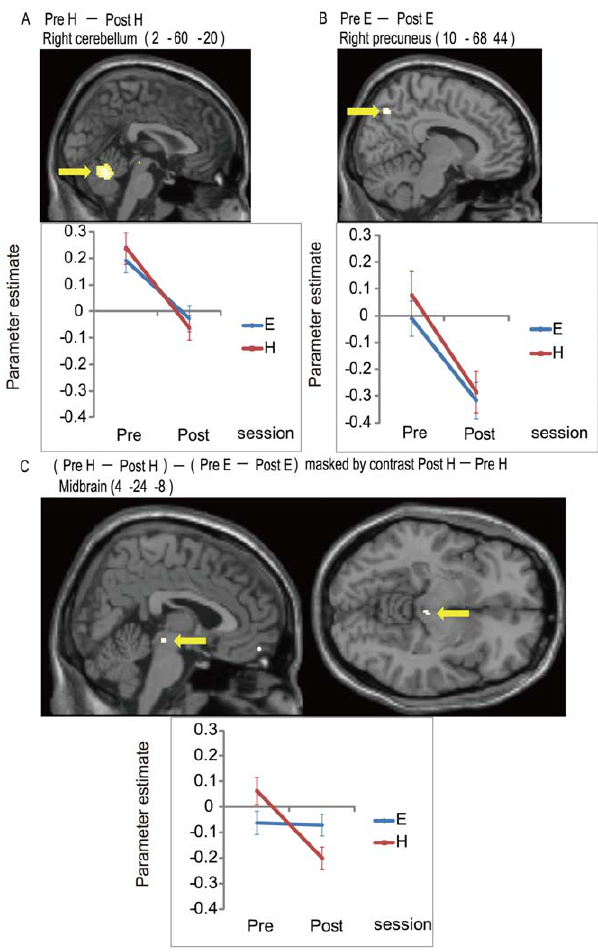
Figure 3. Deactivation related to fatigue and compensatory effort (n=29). All voxels were significant at a statistical threshold of p , 0.05 for family wise error (FWE) corrected for multiple comparisons. Fatigue-induced deactivation in the H condition (i.e., PreH – PostH) (A), fatigue-induced deactivation in the E condition (i.e., PreE – PostE) (B), and deactivation reflecting the compensatory effort (i.e., [PreH – PostH] – [PreE – PostE]) (C). The activation profile of each area represents the parameter estimates in each condition. Errors bar represent the standard errors. The coordinates in the MNI standard space are indicated. E, Easy; H, Hard; Post, the last three runs again in the magnetic resonance imaging (MRI) scanner; Pre, the first three runs in the MRI